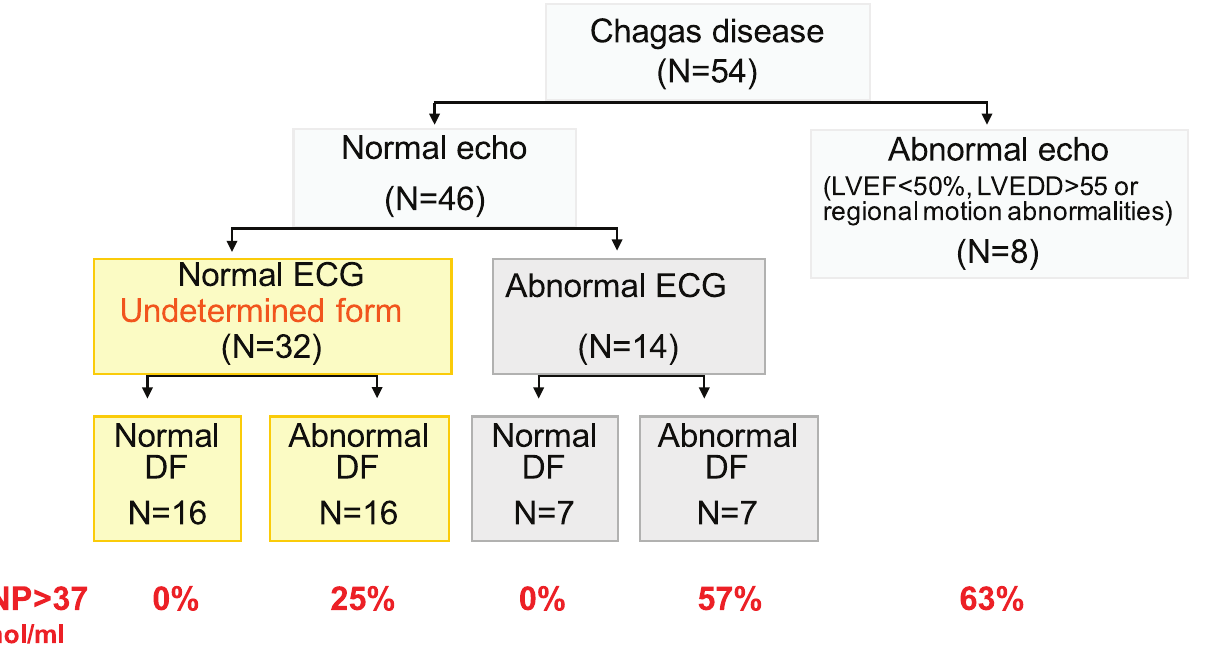
Figure 1. Distribution of patients according to the conventional 2D-echocardiography, ECG and diastolic function and prevalence of pathologic levels of BNP (% of patients). Echo= conventional 2D-echocardiography; ECG= electrocardiogram; DF= diastolic function (assessed by echocardiography); BNP= Brain natriuretic peptide. Normal echo means normality in LV dimensions and LV global and regional systolic function assessed with conventional 2D echocardiography.